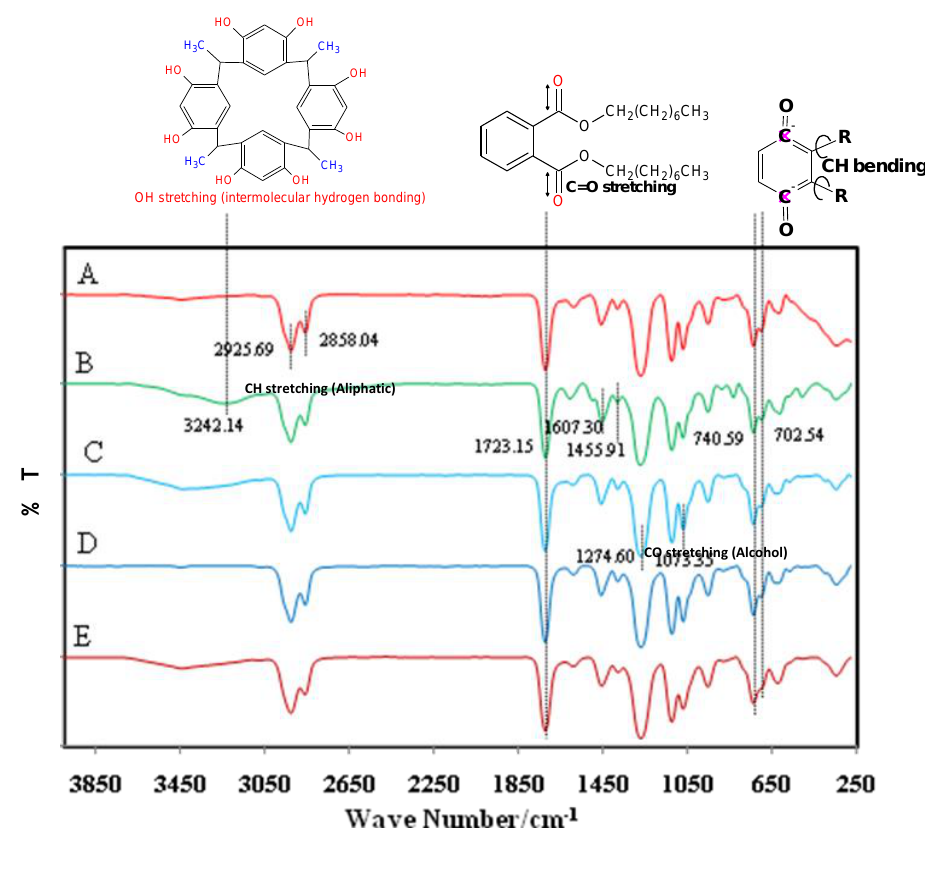
Figure 5. The FT-IR spectra of the membrane PVC sensor based on CMCR ionophore in different states: ( A ) blank membrane, before ( B ), after ( C ) destocking in 1.0 × 10 −3